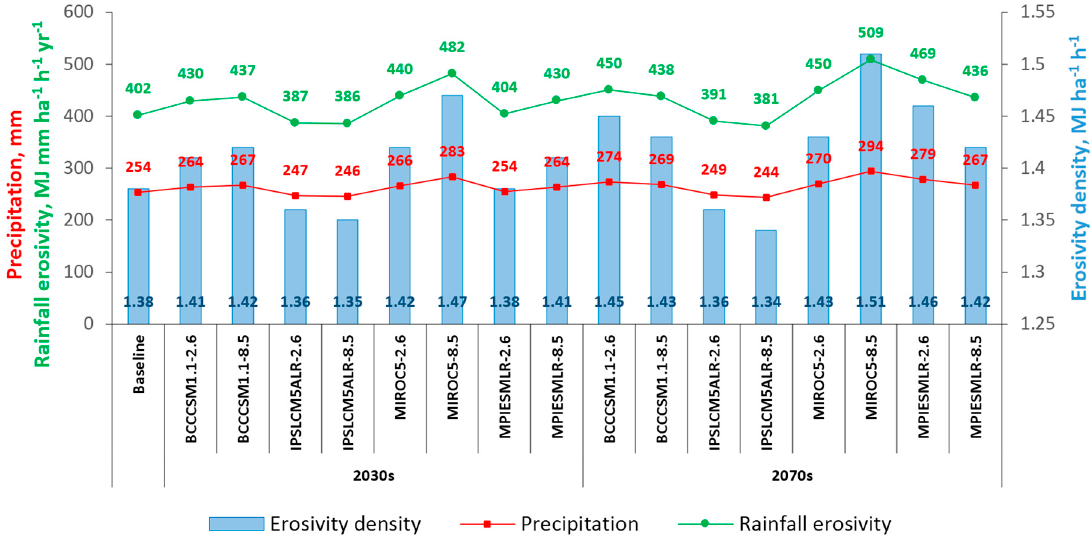
Figure 7. Erosivity density for different scenarios for the period 2030s and 2070s according to RCP2.6 and 8.5 scenarios driven by the BCCCSM1.1, IPSLCM5ALR, MIROC-5, MPIESMLR GCM models.